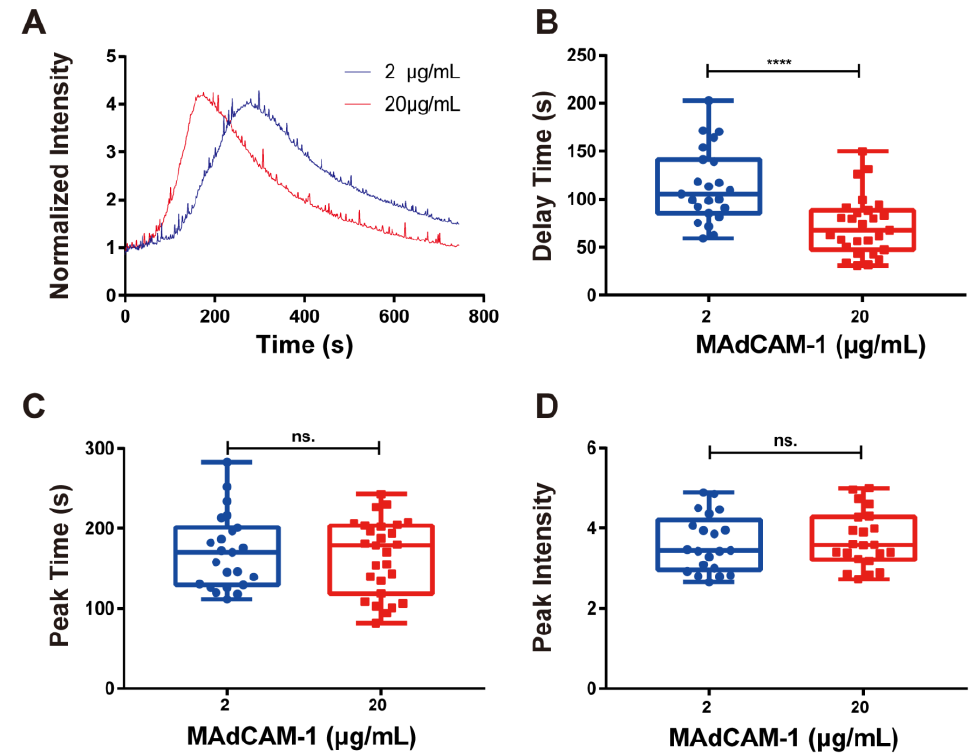
Figure 3. Concentration-dependent calcium signaling. ( A ) Time course, ( B ) delay time, ( C ) peak time, and ( D ) peak intensity of calcium signaling mediated by the interaction of integrin α 4 β 7 with various concentrations of MAdCAM-1 under wall shear stress of 0.3 dyn/cm 2 . Data of each group are shown by boxplot with raw data point, where each horizontal line from top to bottom of a boxplot represents the maximum, upper quartile, median, lower quartile, and minimum for the group, respectively. At least 15 typical calcium signaling events of the firmly adhering cells should be collected among three repeat experiments for each group. Significant differences were shown by p -value, ns. for p > 0.05, **** for p <